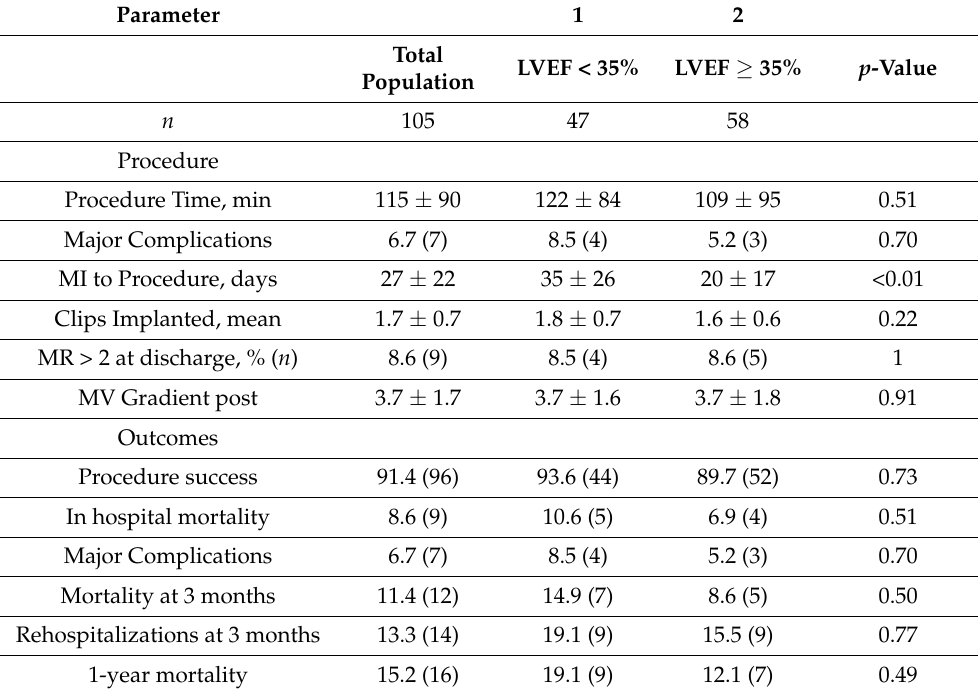
Table 2. Procedure and